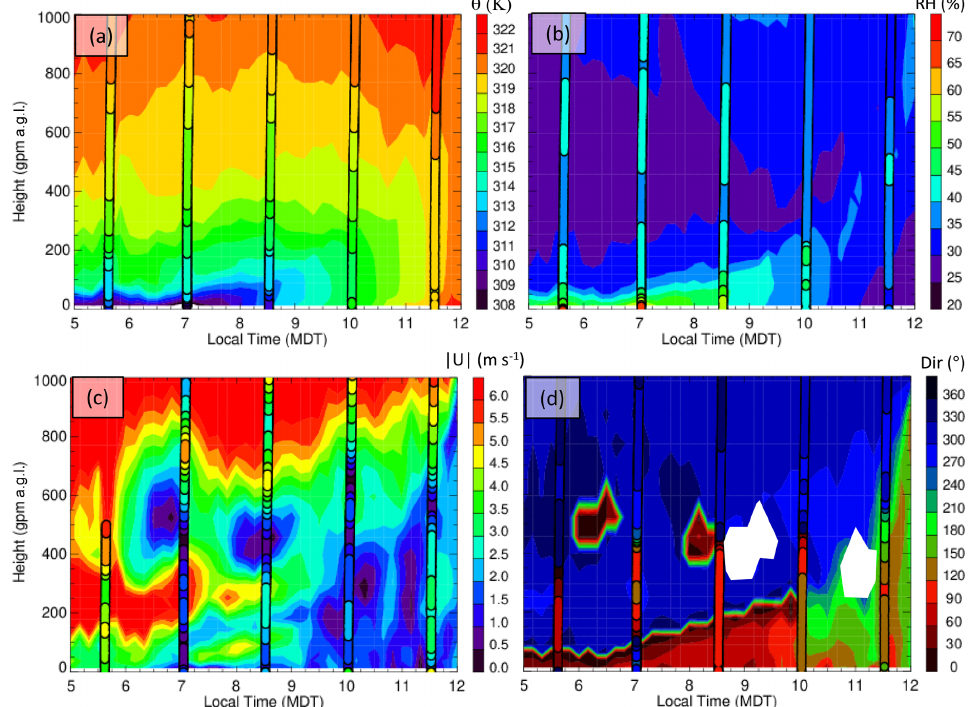
Figure 6. Time–height plots depicting WRF LES modeled evolution of the boundary layer during the drainage flow case observed on 19 July 2018 as evident in (a) potential temperature, (b) relative humidity, (c) wind speed and (d) wind direction. NSSL sounding data are overlaid within vertical columns corresponding with radiosonde launch times. Model data (with 10min output frequency) are from innermost WRF LES grid at grid point closest to 38.05 ◦ N, 160.05 ◦ W. The location of the NSSL soundings on this day is shown in Fig. 1.